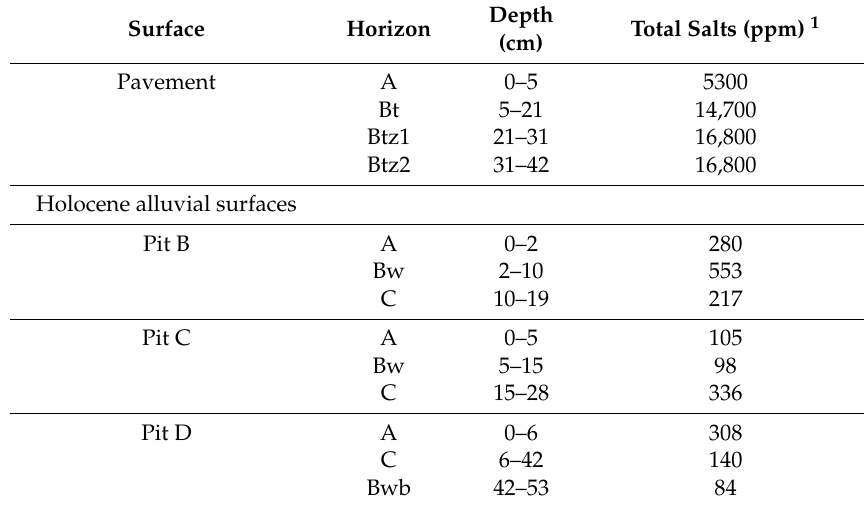
Table 3. Total salt contents of soil horizons sampled on a desert pavement and adjacent Holocene alluvial surfaces at the Tankwa Karoo